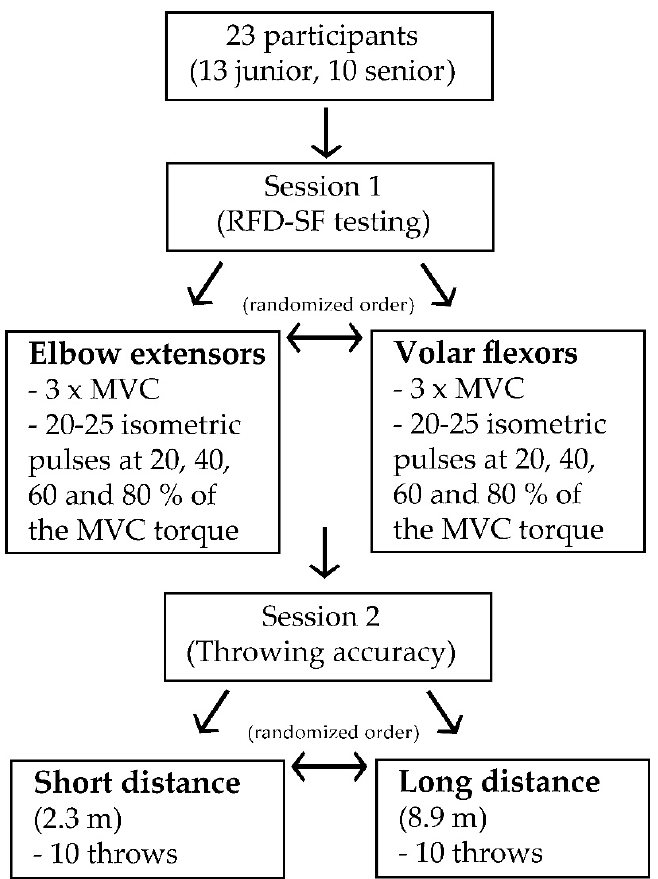
Figure 1. The flowchart of the measurement protocols. MVC—maximal voluntary isometric contraction.